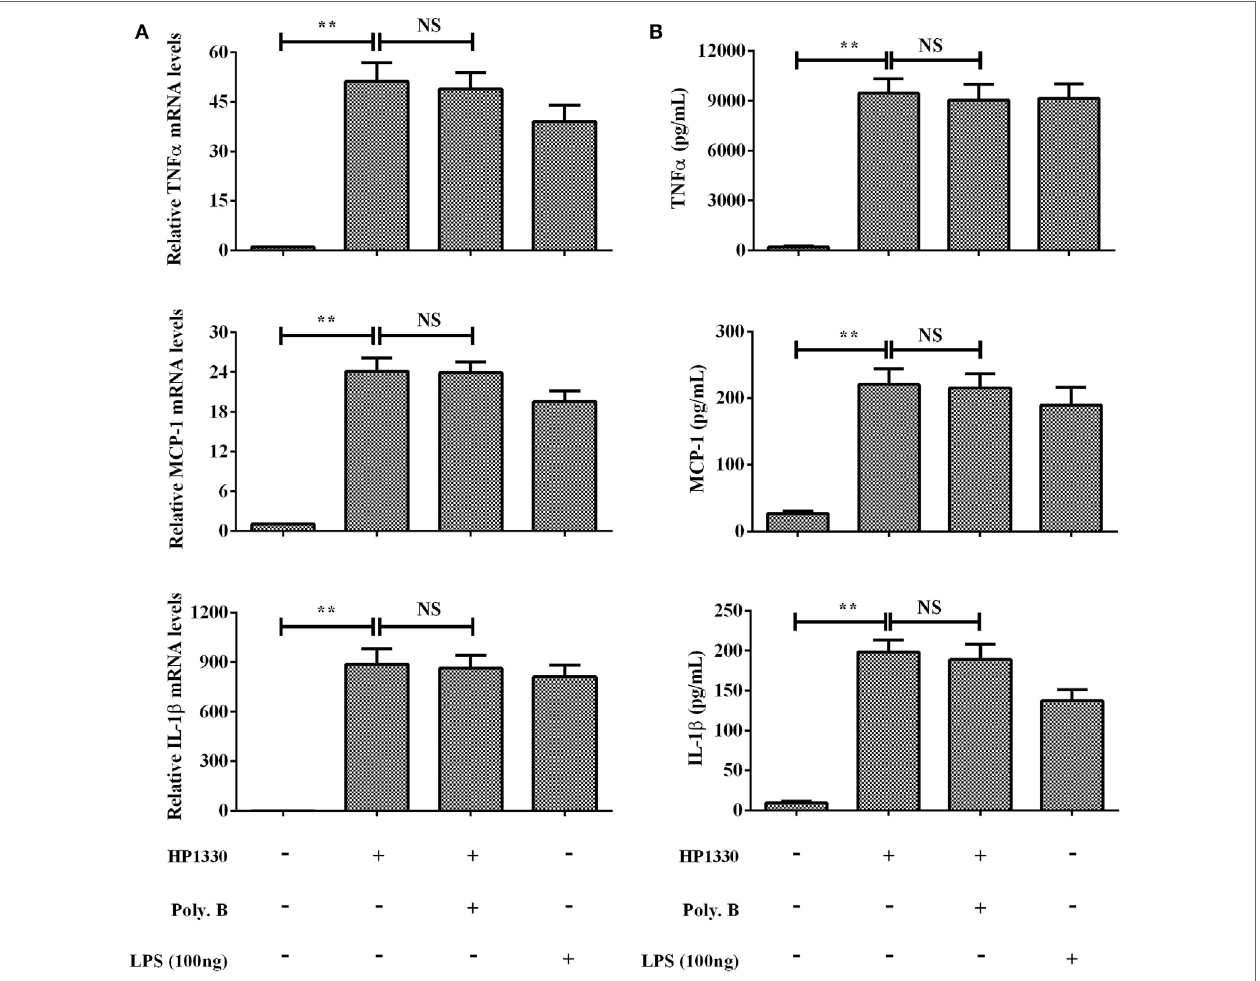
FigUre 2 | Induction of cytokine mRNA and protein expression in RAW 264.7 macrophages by stimulation with recombinant HP1330. RAW 264.7 macrophages were treated with 100 ng ⋅ ml − 1 lipopolysaccharide (LPS) (positive control) or 10 µg ⋅ ml − 1 HP1330 protein in the absence or presence of 10 µg ⋅ ml − 1 Poly.B for 6 h, or with culture medium (negative control). (a) The cytokine mRNA levels were then determined by qRT-PCR, (b) and the protein levels of TNF- α , MCP-1, and IL-1 β in the culture supernatants were determined by enzyme-linked immunosorbent assay. The bars represent the SEMs, based on three independent experiments. ** P <